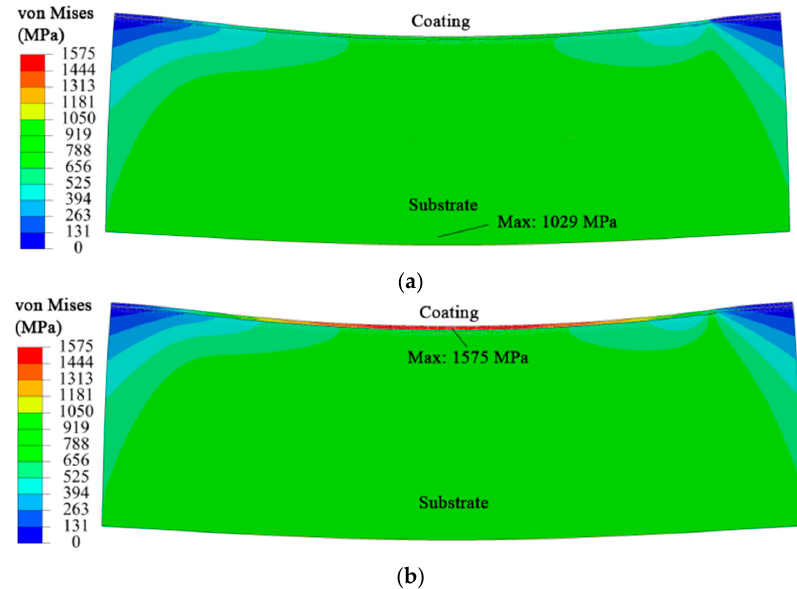
Figure 7. Contour of equivalent stress in the coating–substrate system for ( a ) a soft coating and hard substrate and ( b ) a hard coating and soft substrate.